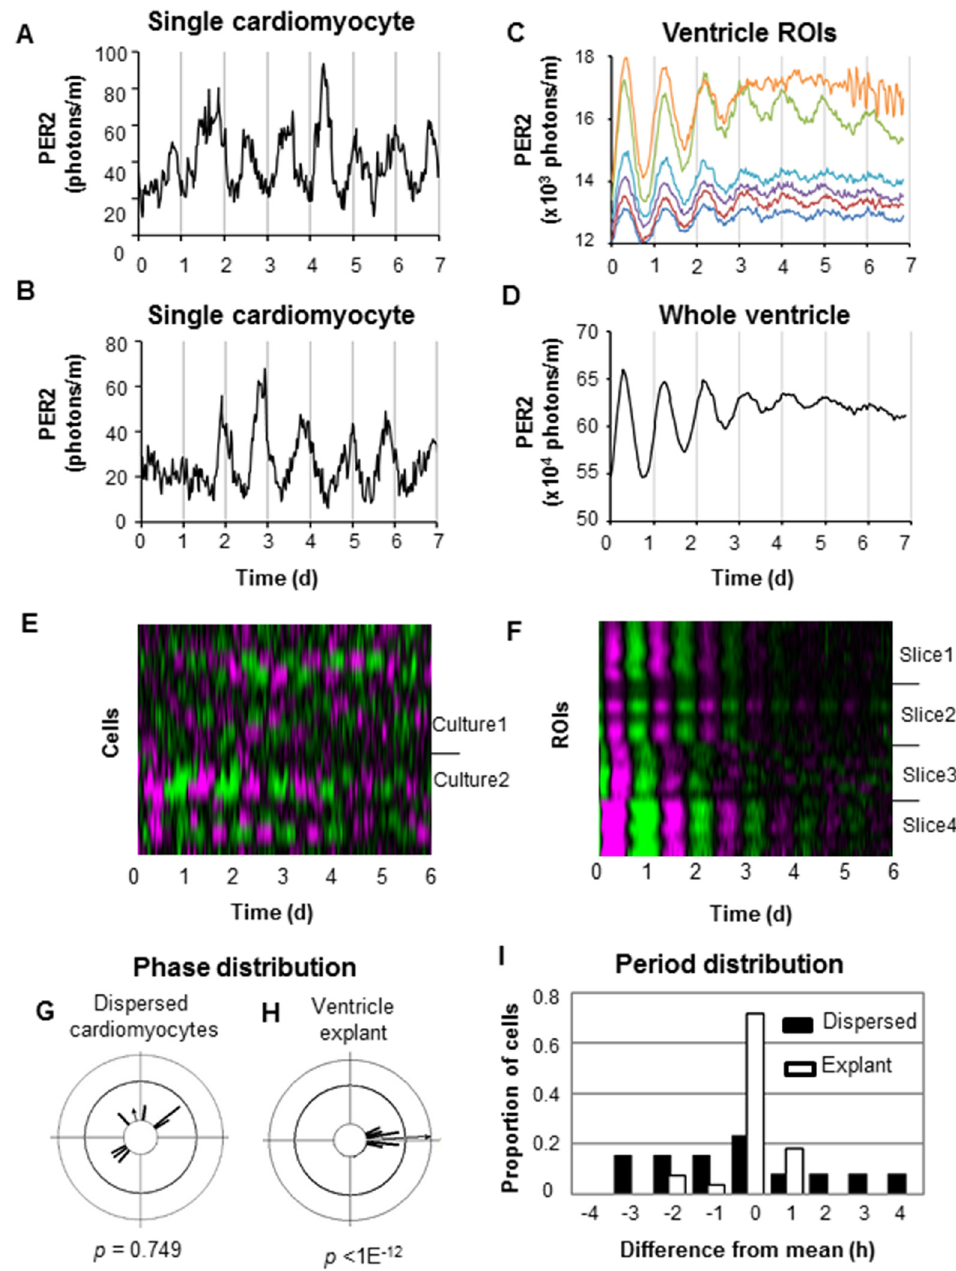
Fig 2. Imaging of PER2::LUC rhythms in dispersed single cardiomyocytes and cell-sized regions of ventricular tissue. Dispersed PER2::LUC cardiomyocytes or 300 μ m ventricular explant cultures were placed under a CCD camera and imaged for 6 – 7 days. (A- B) PER2::LUC oscillations of two single cardiomyocytes in the same dispersed culture. (C-D) PER2::LUC oscillations of randomly placed cell-sized regions of interest (ROIs) in a ventricle explant (C) and of a whole ventricle (D). (E-F) Raster plots depicting PER2::LUC oscillations of 16 single cardiomyocytes in 2 dispersed cultures (9 in culture 1, 7 in culture 2) (E) and ROIs from 4 ventricular slices (n = 7 ROIs per slice) (F), with higher than average bioluminescence intensity coded by magenta and lower than average intensity by green. Each row is a single cell (E) or ROI (F). In E, cells were ordered by the time of peak in the interval 0.6 – 1.6 d. In F, ROI ’ s were ordered randomly. Time is relative to start of recording. (G-H) Phase distributions of dispersed cardiomyocytes (G) and regions in a representative explant (H) are shown as Rayleigh plots. p -values are from Rayleigh tests for synchrony. (I) Distribution of periods of dispersed cardiomyocytes and explant culture ROIs. Proportions of all 13 rhythmic single cardiomyocytes or of all 28 cell-sized ROIs are shown on the y-axis. Differences from the mean